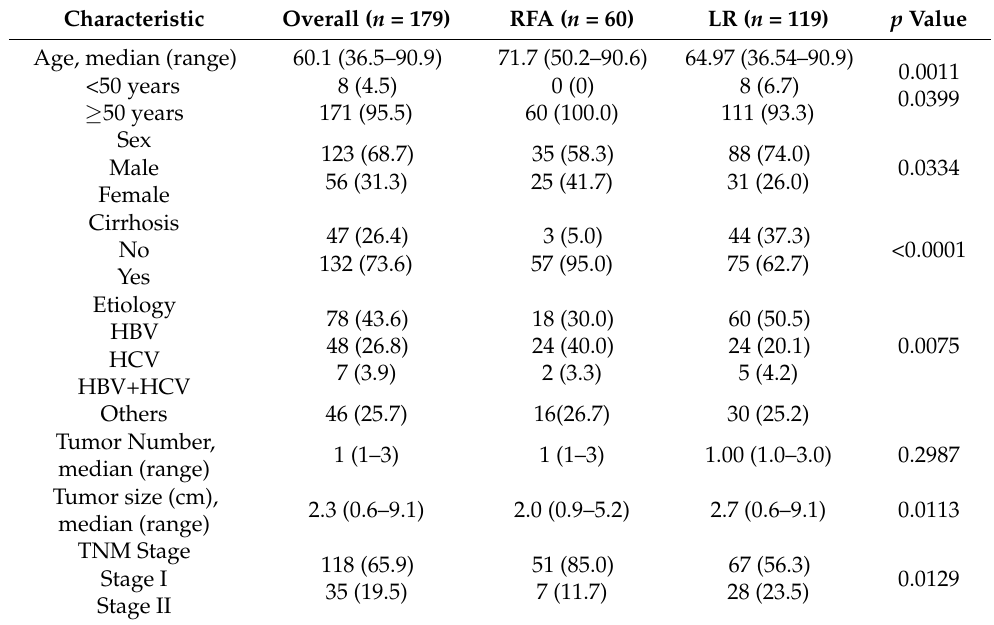
Table 1. Demographic features of patients undergoing curative treatment for hepatocellular carci- noma at left lateral